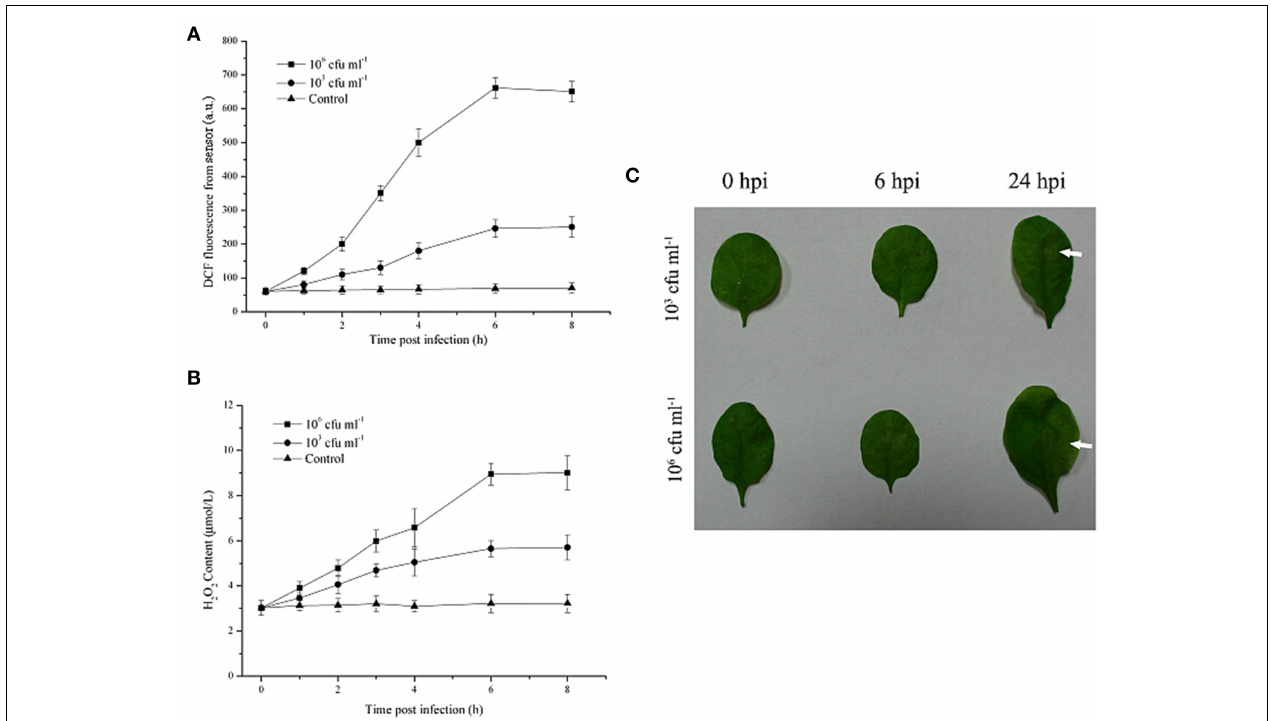
FIGURE 3 | The early monitoring of Pseudomonas syringae pv. tomato DC3000 ( Pst DC3000) infection in A. thaliana leaves by the optical sensor through detection of the ROS production dynamics. The DCF fluorescence was determined by the optical device at 2, 4, 6, 8 hours post infection with 10 6 cfu ml − 1 or 10 3 cfu ml − 1 Pst DC3000 (A) . The mean ± SD of the fluorescence intensity is shown for five independent A. thaliana leaves inoculated with 10 3